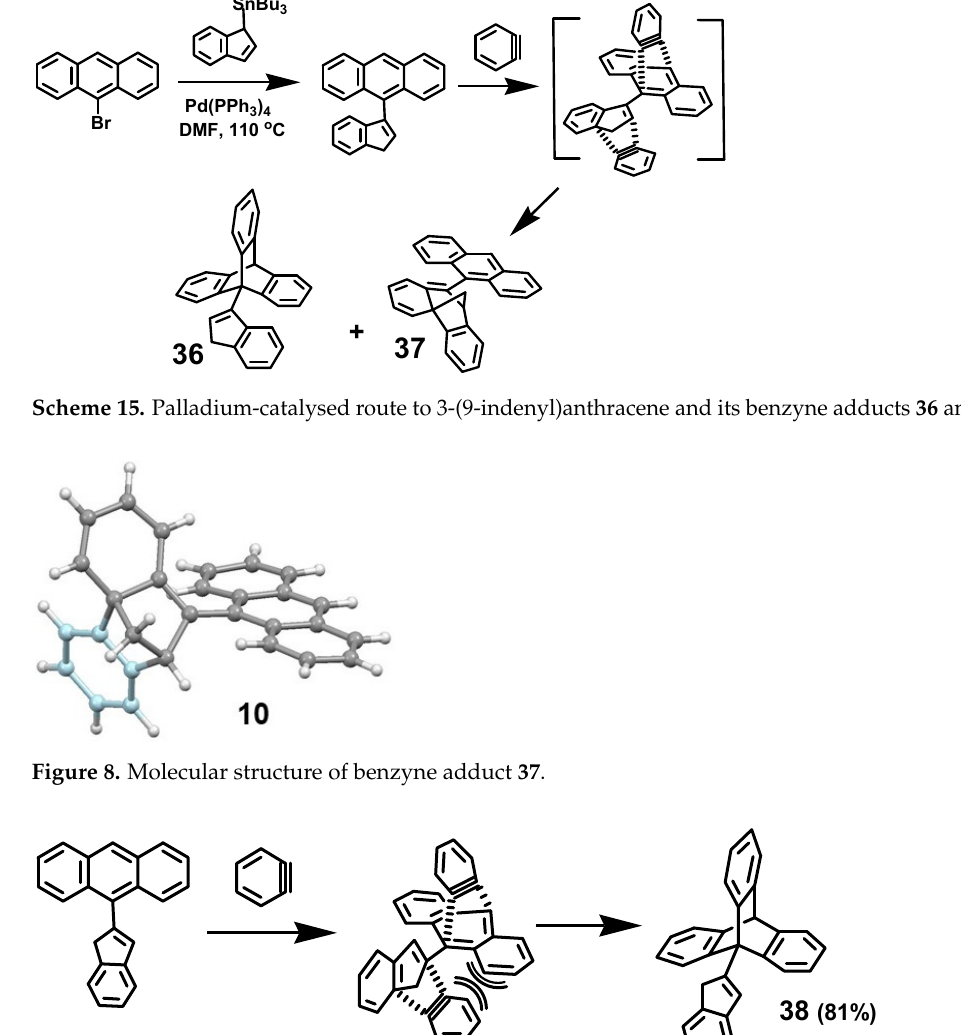
Scheme 16. Reaction of benzyne and 9-2(indenyl)anthracene yields only a single adduct, 38 .